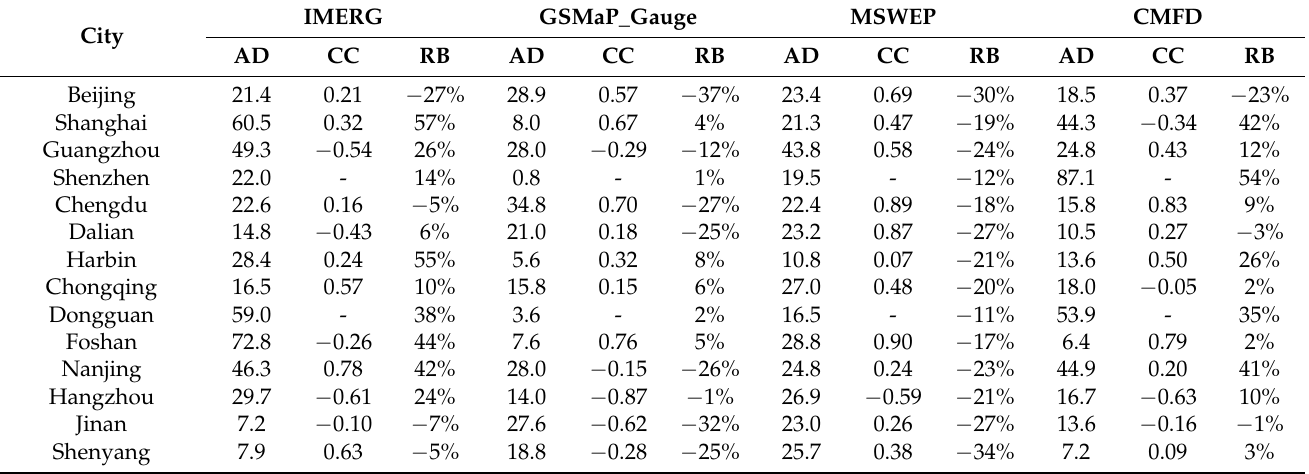
Figure 8. The absolute deviation between R99TOT values of SPPs data and rain gauges in 21 major cities: ( a ) IMERG, ( b ) GSMaP_Gauge, ( c ) MSWEP, and ( d ) CMFD. Table 5. The difference of R99TOT between the SPPs data and gauge observations in 21 major